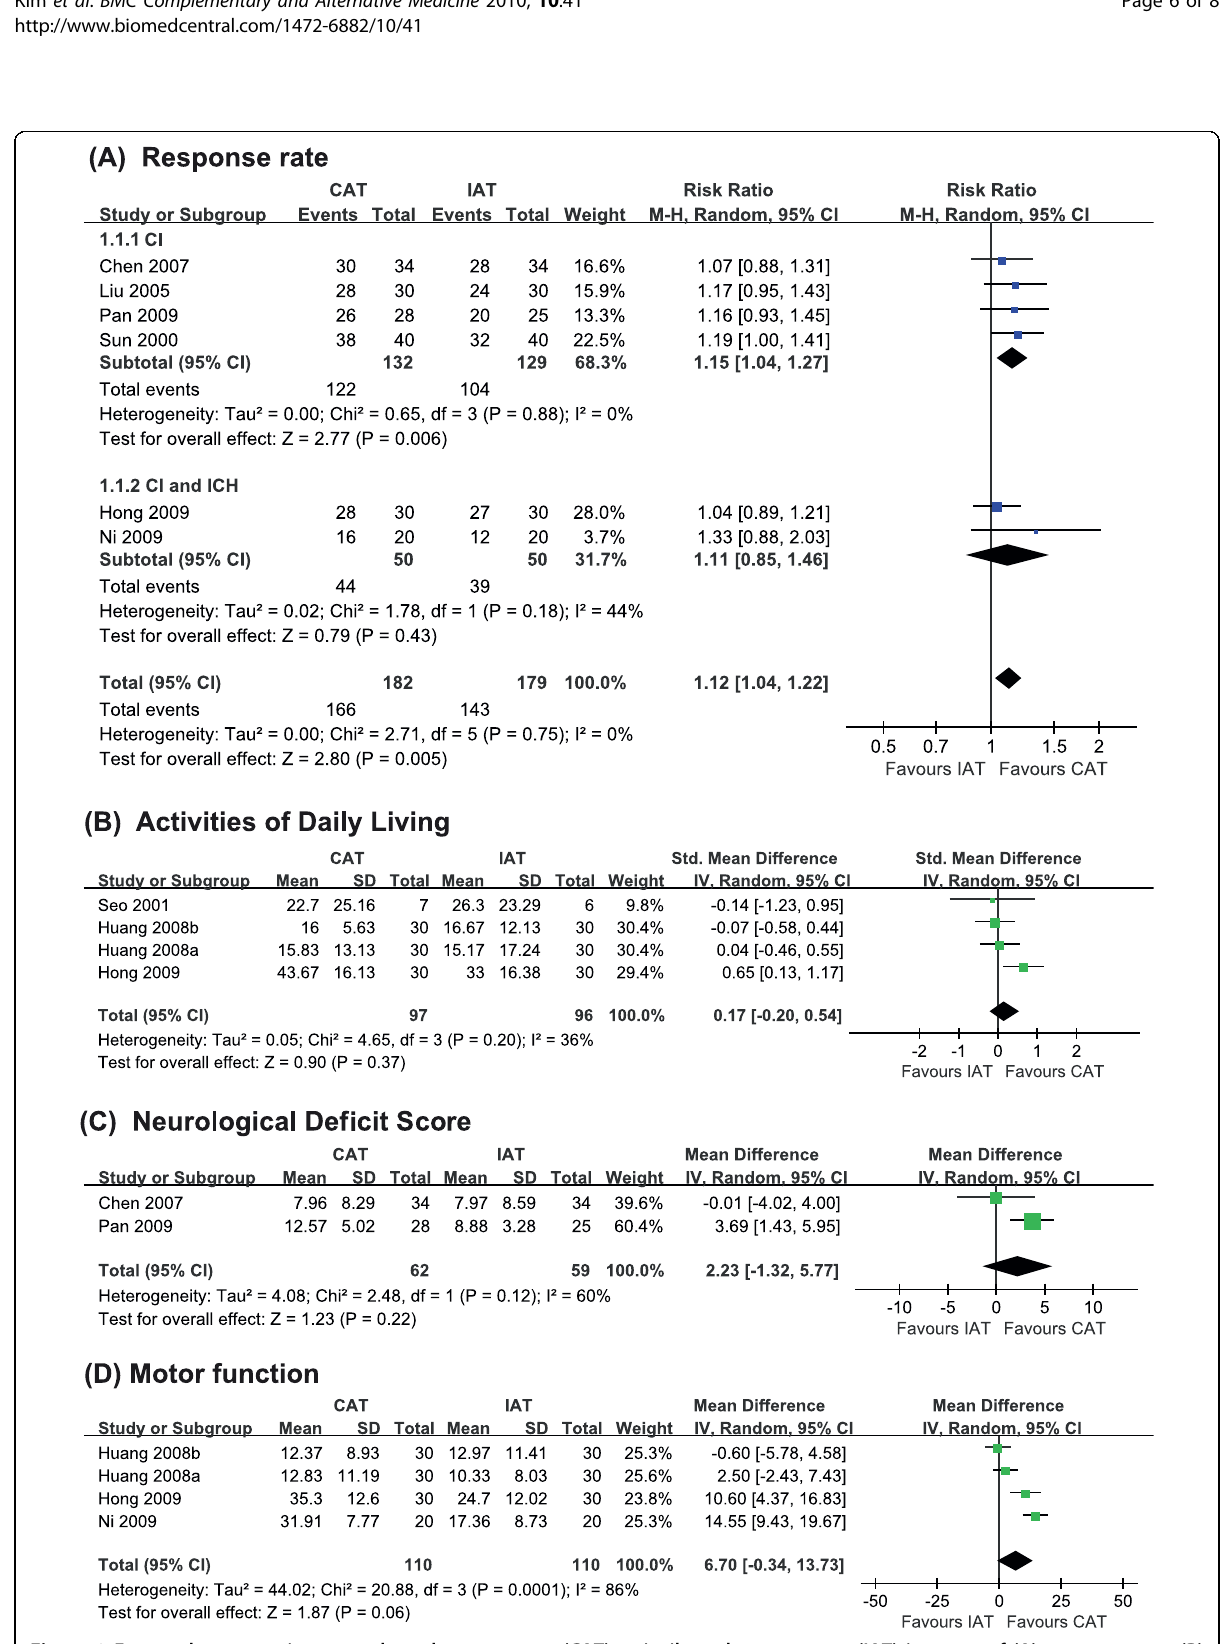
Figure 2 Forest plot comparing contralateral acupuncture (CAT) to ipsilateral acupuncture (IAT) in terms of (A) response rate, (B) Activities of Daily Living, (C) Neurological Deficit Score, and (D) motor function in post-stroke hemiplegic patients . CI: cerebral infaction; ICH: intracranial